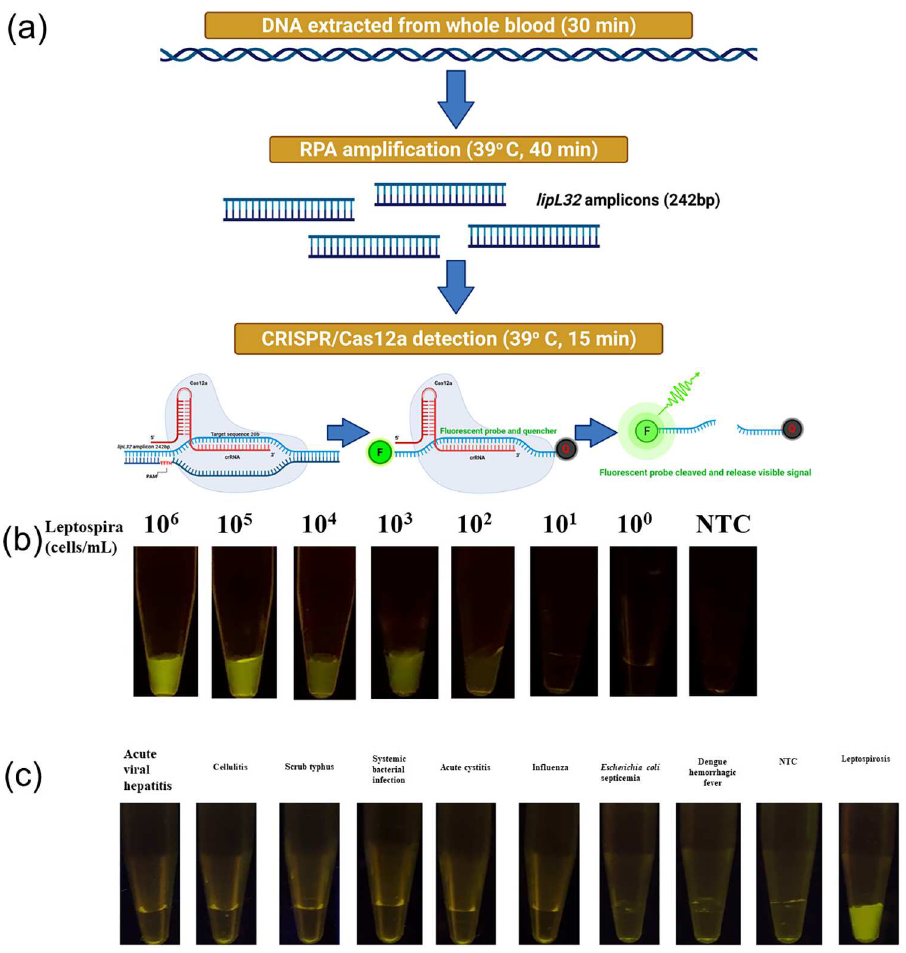
Fig 1. Detection of leptospirosis using the RPA-CRISPR/Cas12a-FBDA. (A) Schematic representation of the RPA-CRISPR/Cas12-FBDA’s workflow (Created with BioRender.com). (B, C) The (B) LOD and (C) cross-reactivity of the RPA-CRISPR/Cas12a targeting lipL 32 gene against several infectious diseases with similar clinical manifestations as leptospirosis.